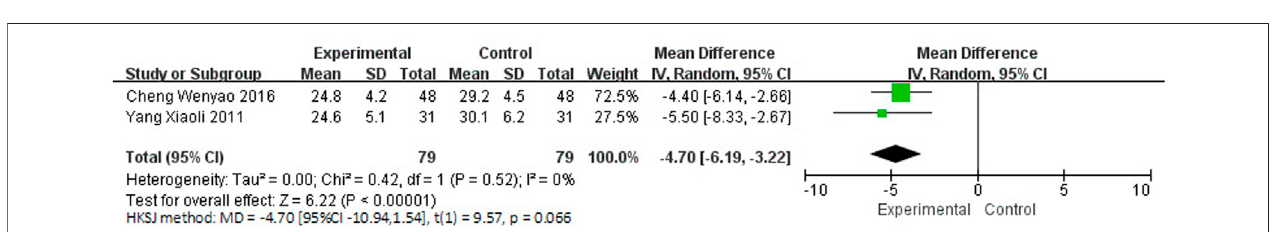
FIGURE 9 | Meta-analysis of ADL by NBP as